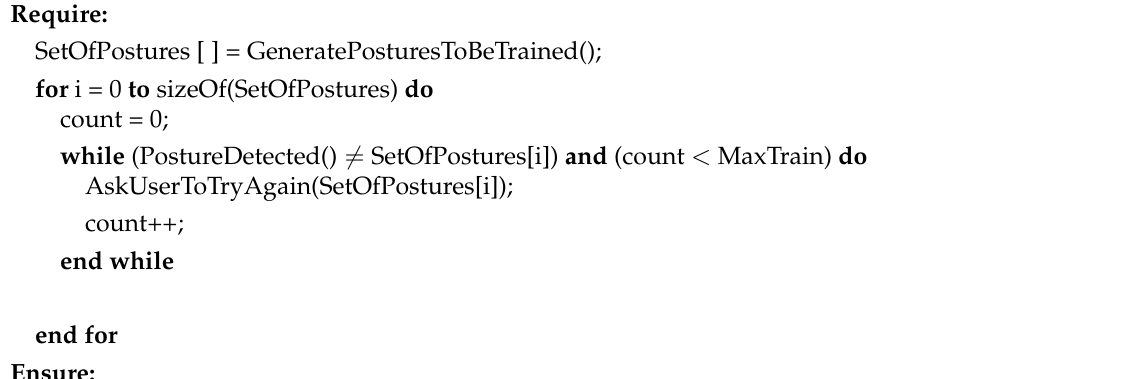
Algorithm 2 TakeActions algorithm for static postures